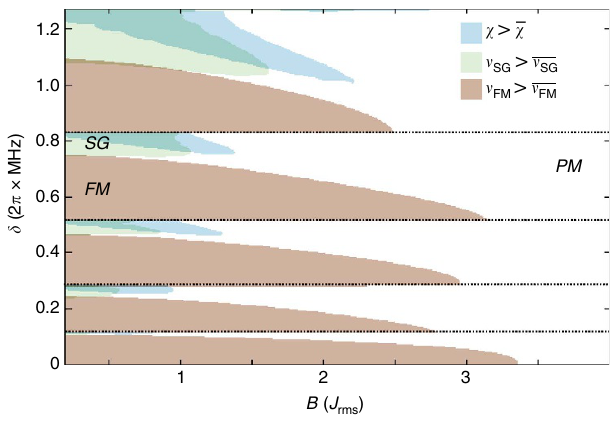
Figure 3 | Magnetic phases. On varying the laser detuning d and the transverse magnetic field B , we mark, for N ¼ 6 ions and o z ¼ 2 p (cid:2) 770kHz, those regions in configuration space where the ferromagnetic order parameter n FM , the spin glass order parameter n SG , or the longitudinal magnetic susceptibility w take larger than average values ( n FM ¼ 0.13, n SG ¼ 5, w ¼ 1.6). Below each phonon resonance (marked by the dashed horizontal lines), there is a regime where large values of n SG and w indicate spin glass behaviour for sufficiently weak transverse field B . To break the Z 2 symmetry of the Hamiltonian, all quantities were calculated in the presence (with E ¼(cid:3) J rms of a biasing field Es 1 x